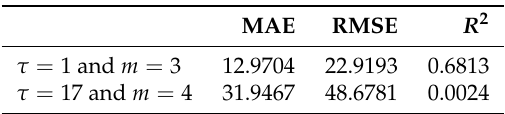
Table 4. Multilayer Perceptron: Mean squared error.